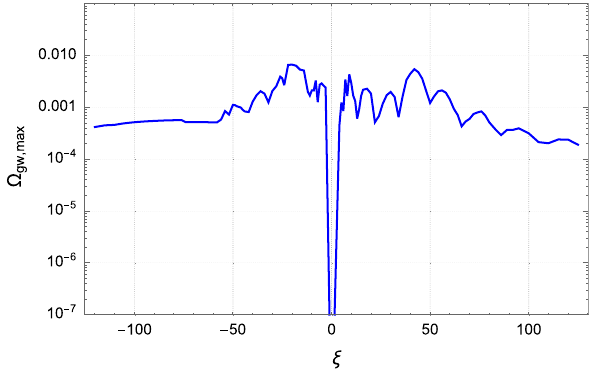
Fig. 4 The amplitude for the final GW density spectrum peak as a function of ξ